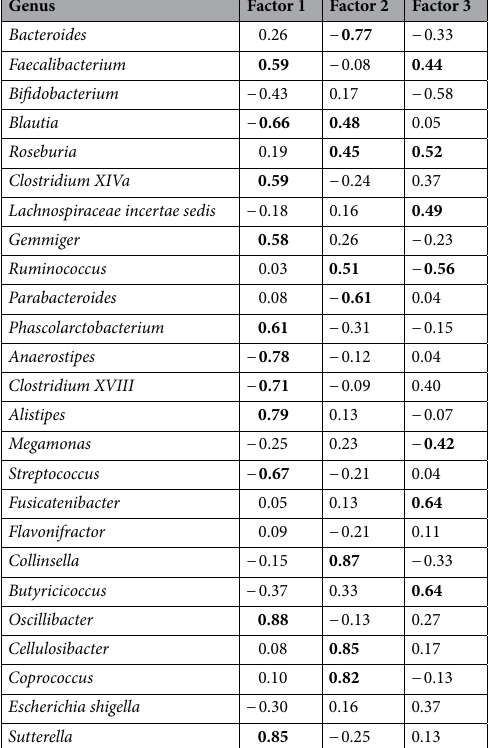
Table 2. Bacterial coabundance factor loadings for the 25 most abundant gut microorganisms (n = 46 children). Factor loadings > |0.40| are bolded.